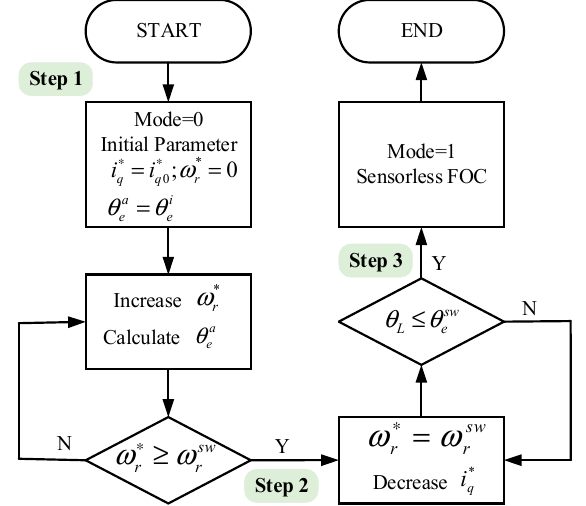
Figure 3. The I-f startup strategy flowchart.